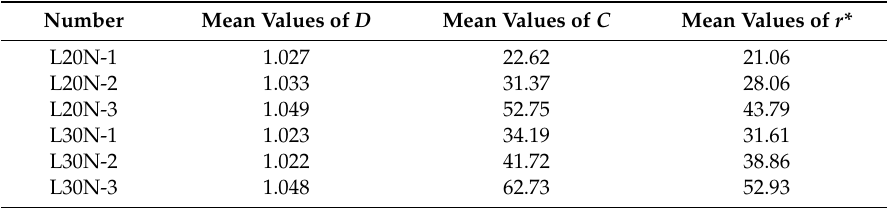
Table 6. Mean values of the